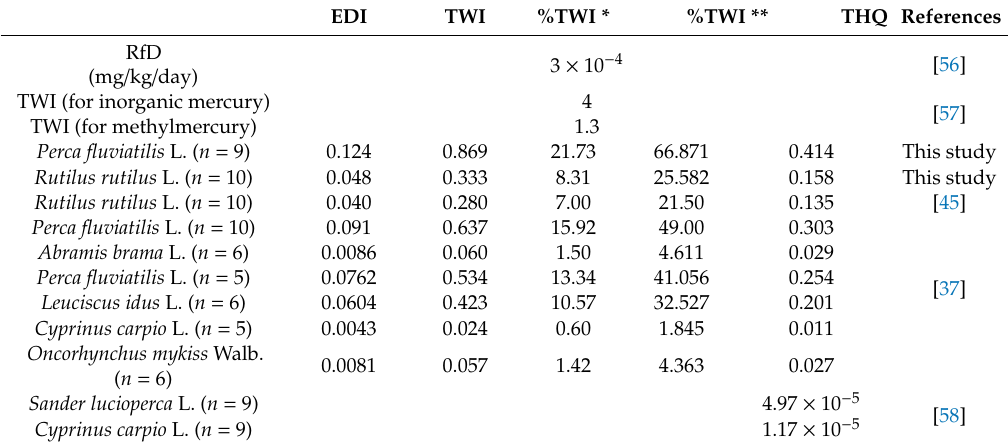
Table 3. The hazard quotient calculated for mercury content in the muscle tissue of the fish examined.